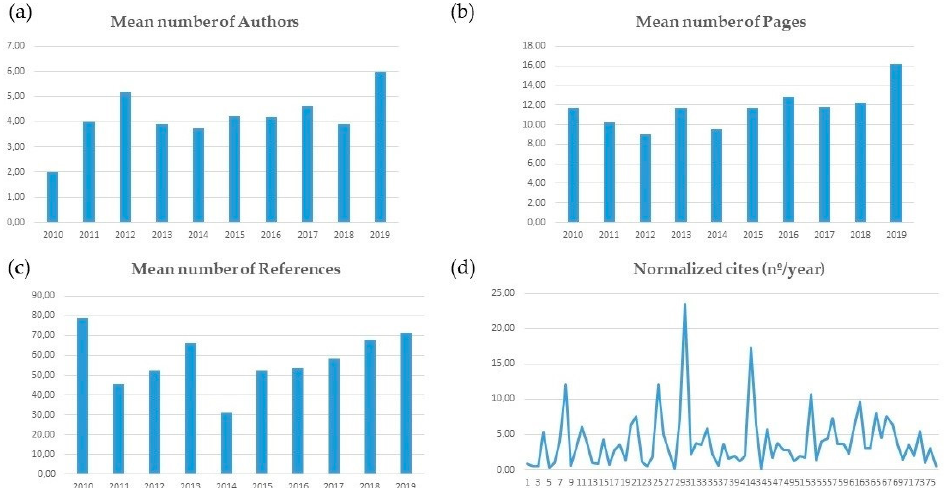
Figure 3. Time trends in scientific production over the last decade on protected areas’ ecological effectiveness: ( a ) mean number of authors per year; ( b ) mean number of pages per year; ( c ) mean number of references contained in articles published each year; ( d ) normalized citations of each article, from 1 (2010) on the left on the x-axis to 76 (2019) on the right.